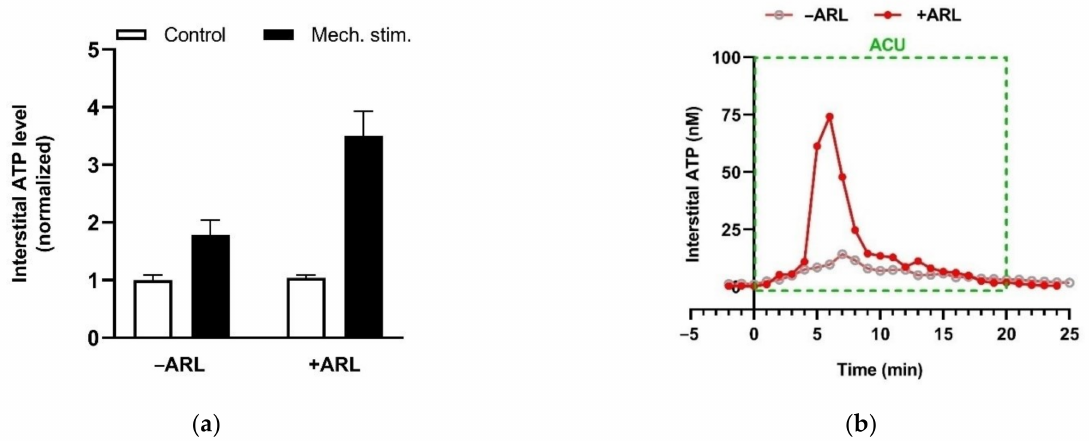
Figure 16. Ecto-nucleotidase activities in MCs in vitro and in rats acupoint in vivo. ( a ) Mechanosen- sitive ATP release from rat MCs (RBL-2H3 cell line) (averages + SEM, n = 4). Medium displacement- induced ATP release was measured in the absence or presence of ARL67156 (100 µ M) ( n = 6–11). ARL67156 was pre-introduced to cell suspension 20 min before mechanical stimulation. ( b ) Potenti- ating effect of ecto-nucleotidase inhibition on acupuncture-induced eATP accumulation in ST36 of ankle AA rats. Representative trace of acupuncture-induced eATP accumulation in the absence or presence of ARL67156 (100 µ M), a non-specific antagonist of ecto-nucleotidases, in the microdialysis solution ( n = 4). Establishing the inflammation pain and acupuncture intervention was referred to the legend of Figure 5. The data are based on Wang et al. 2020 [83] and Zuo et al. 2022 [74].